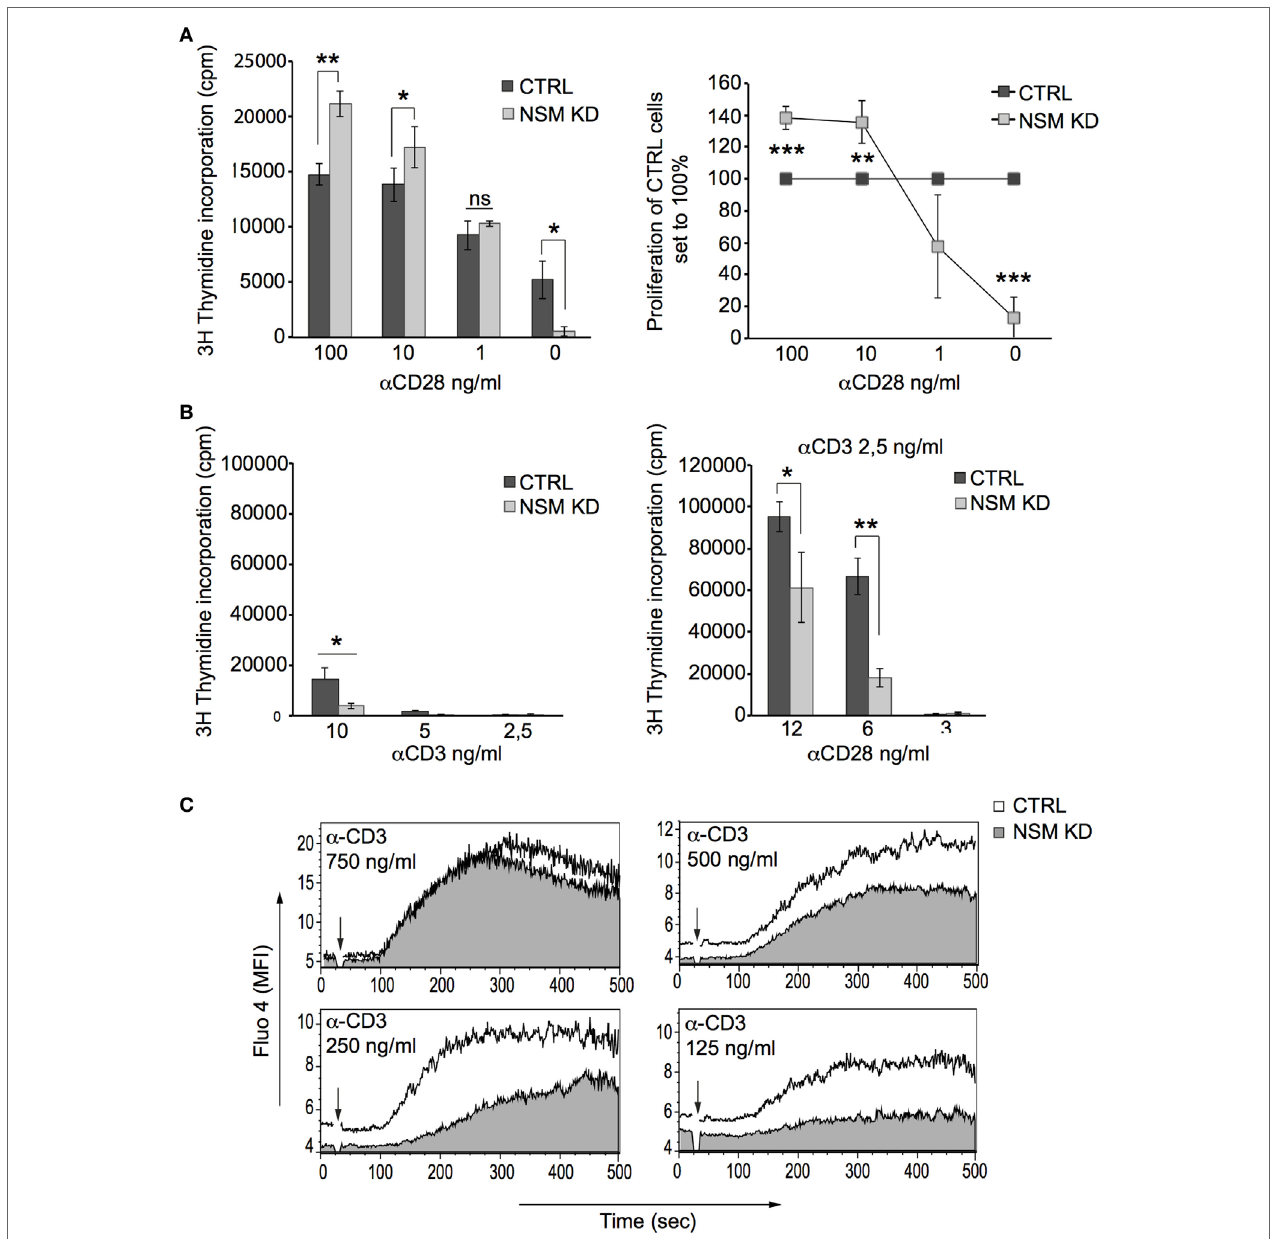
FigUre 2 | NSM is required for T cell receptor signal amplification at low antigen dose. (a) Proliferation of α -CD3-stimulated (0.1 µg/ml) CTRL (black bars) and NSM KD cells (gray bars) co-stimulated with decreasing concentrations of α -CD28 antibodies was determined after 72 h (left panel and proliferation of NSM KD cells normalized to that of CTRLs, right panel). (B) Expansion rates were determined in CTRL (black bars) and NSM KD cells (gray bars) stimulated by decreasing concentration of α -CD3 antibodies alone (left panel) or by constant α -CD3 (2.5 ng/ml) with decreasing concentrations of α -CD28 antibodies after 72 h. (c) Fluo-4 emission signals were recorded in CTRL (white profiles) and NSM KD cells (gray profiles) stimulated by decreasing concentrations of α -CD3 antibodies by flow cytometry over time. One representative out of three independent experiments is shown. The time point of α -CD3 addition is marked by arrow in each